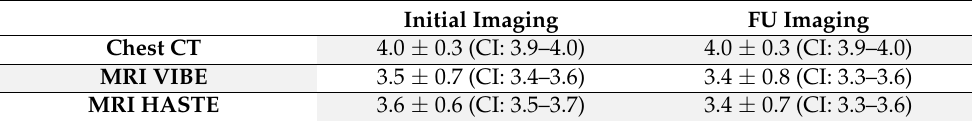
Table 4. Image quality at initial imaging and follow-up (FU) imaging according to a four-point Likert scale (1—very poor image quality to 4—excellent image